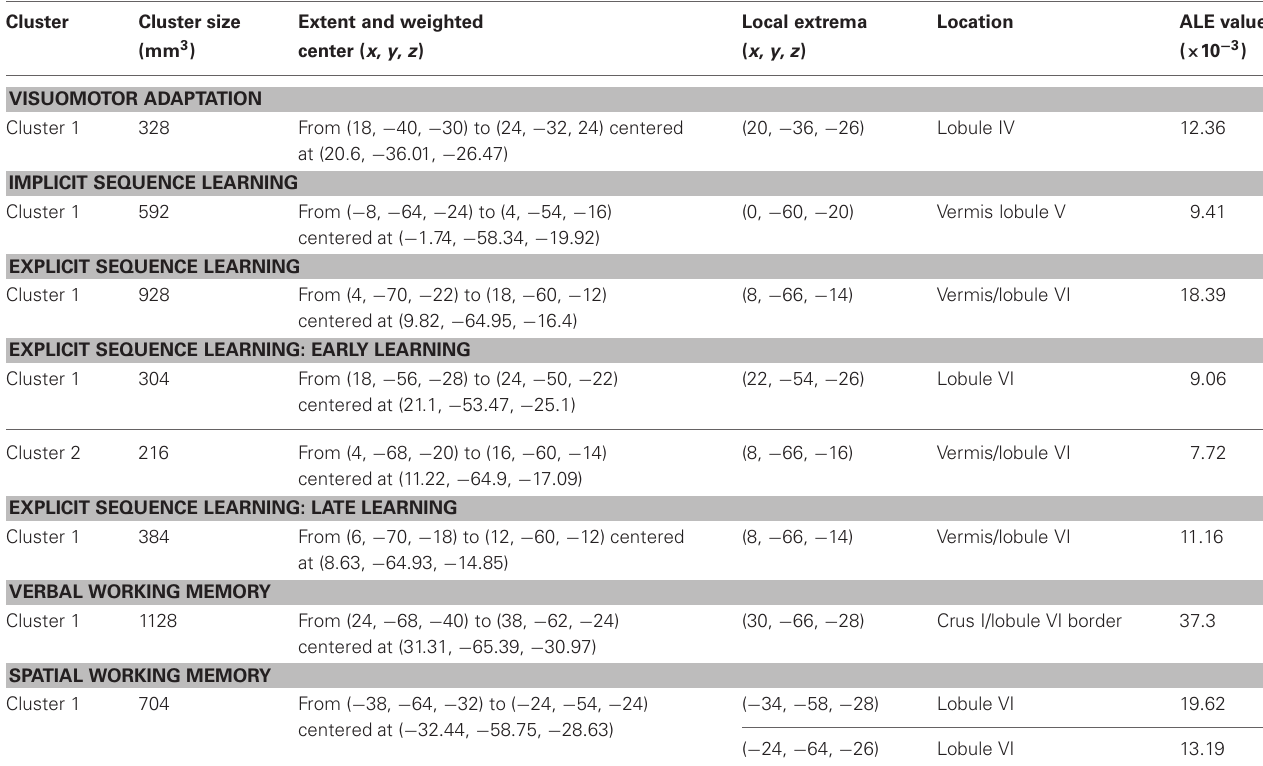
Table 2 | Peak ALE coordinates for each task